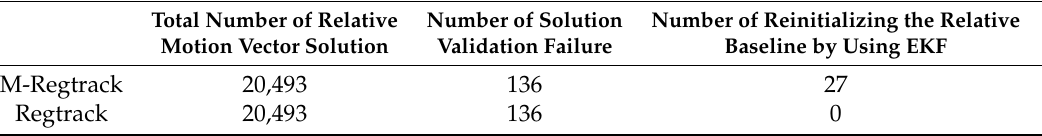
Table 2. The validation status of the relative motion vector solutions: kinematic experiment Section